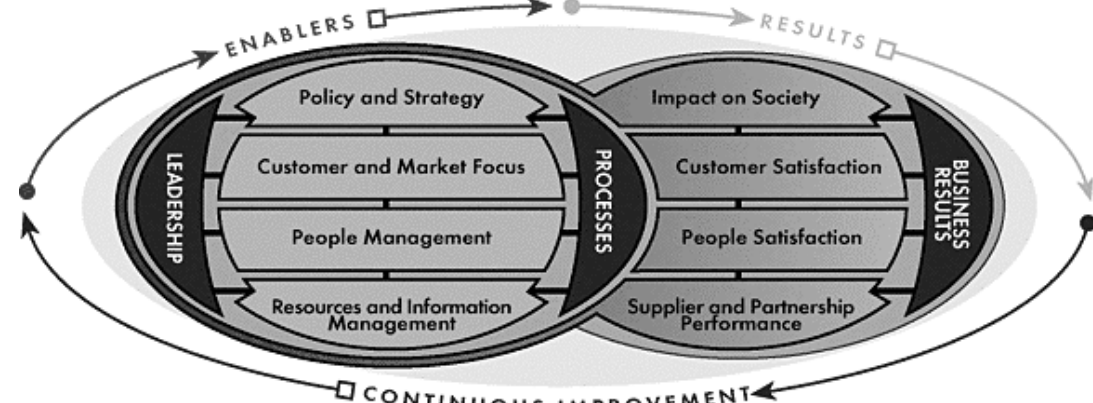
Figure 1: The South African Excellence Model (sourced from www.saef.co.za, Feb